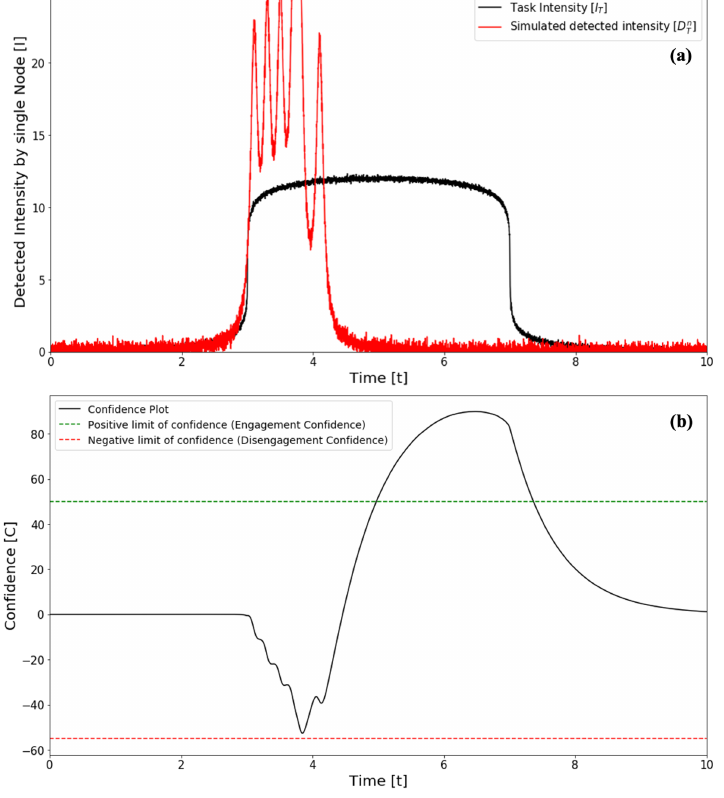
Figure 3. ( a ) Simulation of node moving radially through the center of a task where randomly assigned nodes are performing the task close to its radius. ( b ) The equivalent Confidence Function for the simulated scenario is